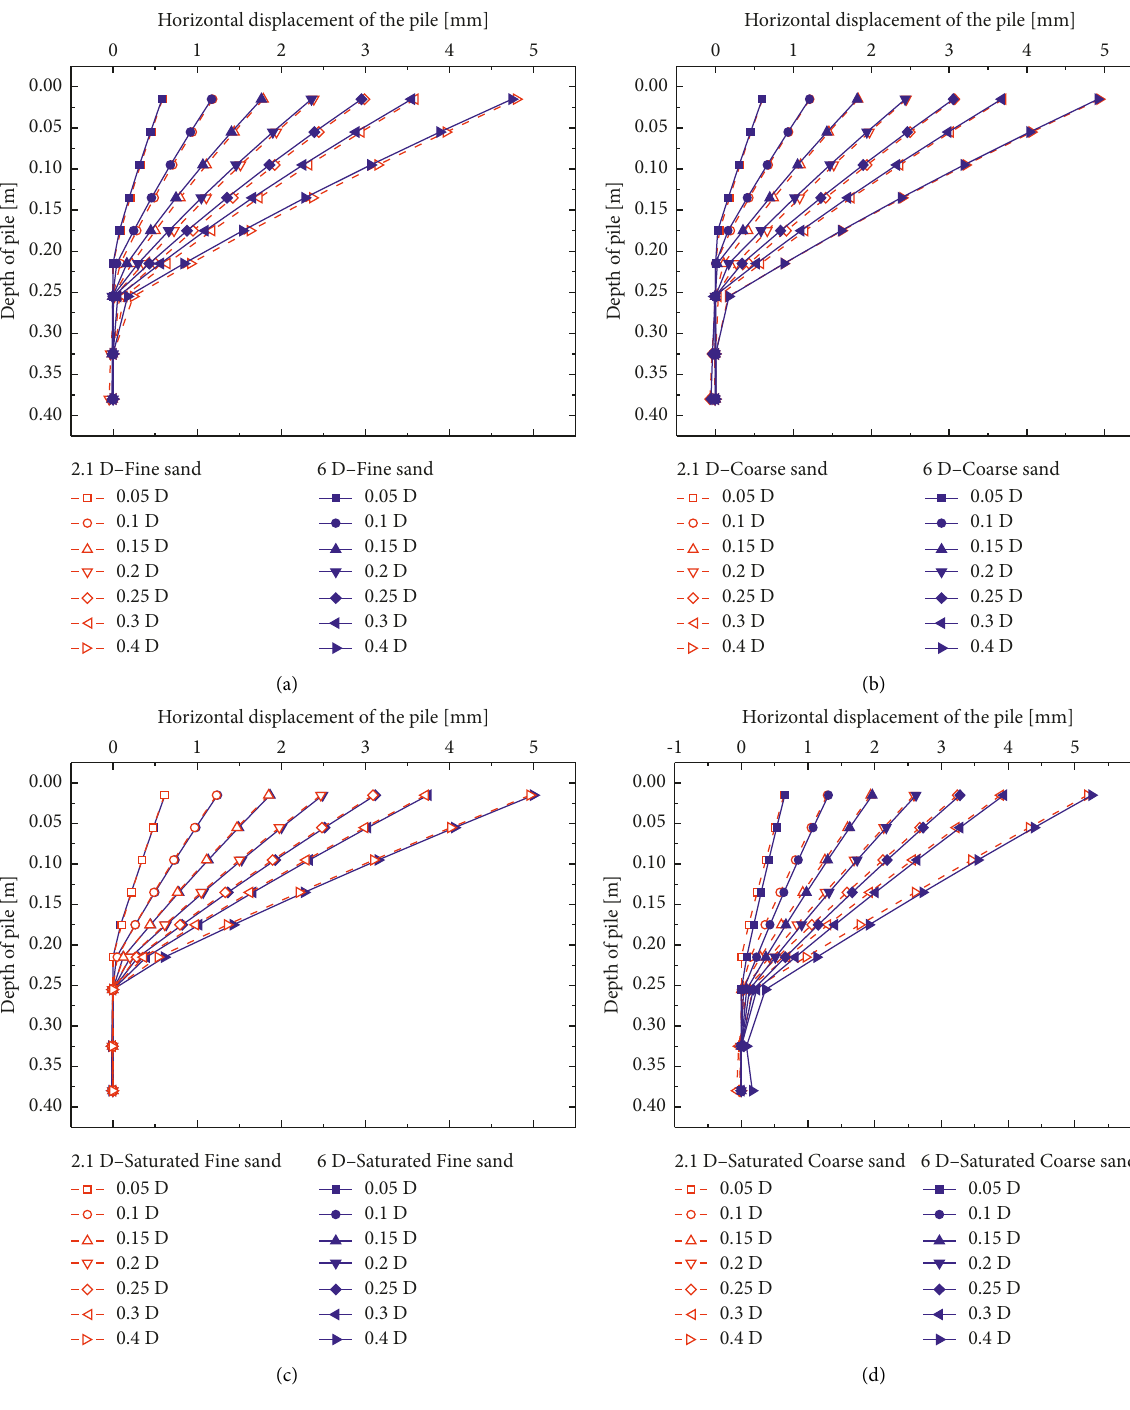
Figure 6: Comparison of pile displacement under different loading heights. (a) Fine sand, (b) coarse sand, (c) saturated fine sand, and (d) saturated coarse